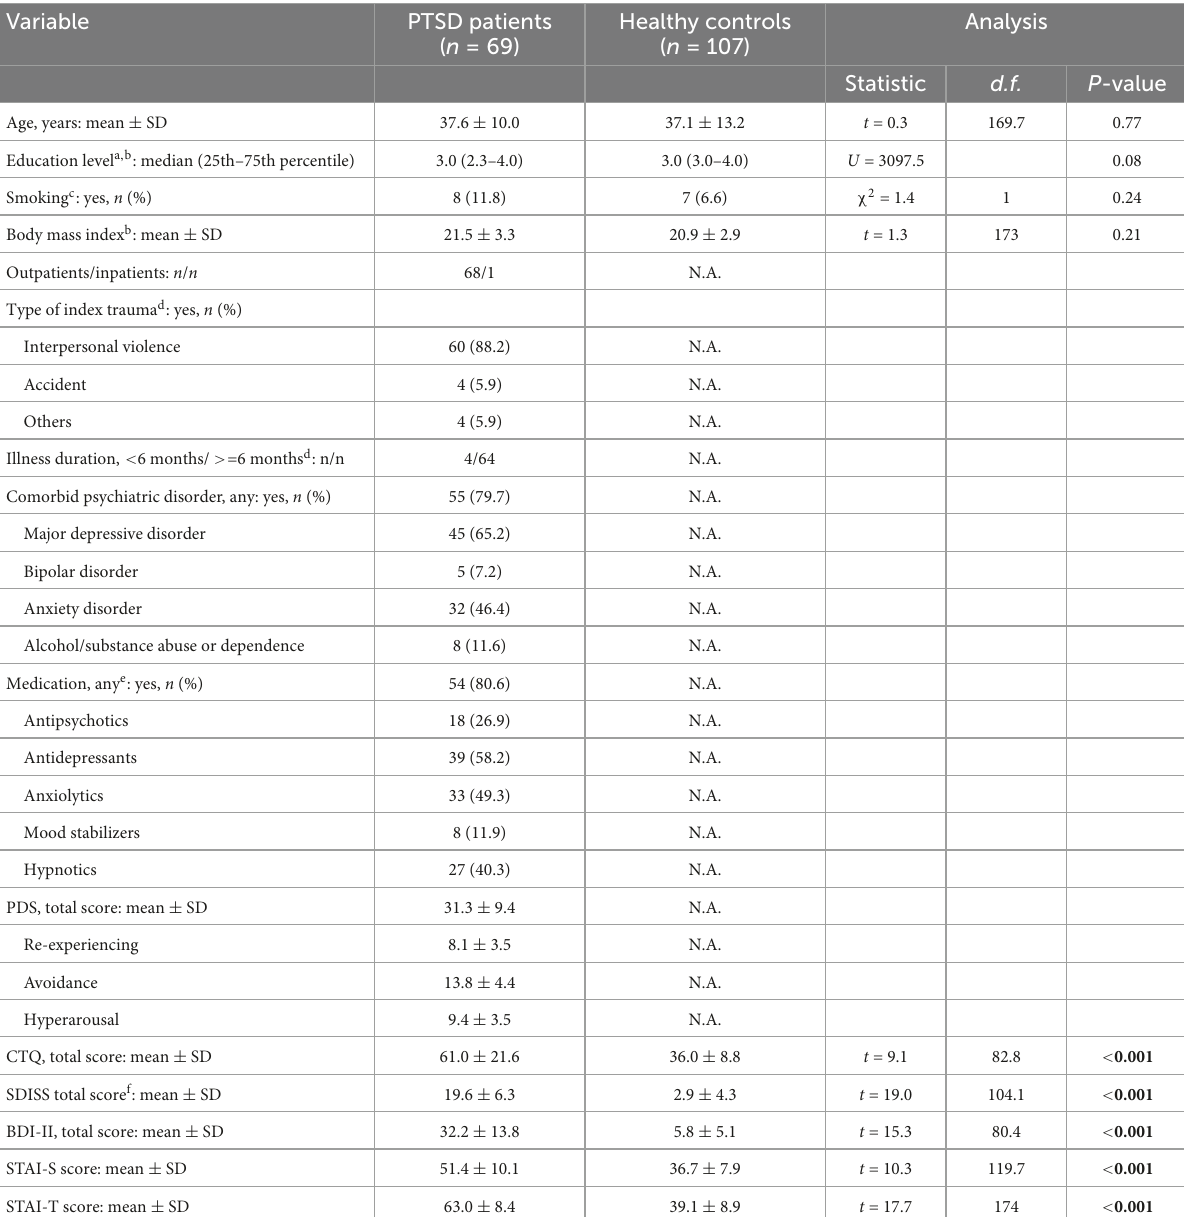
TABLE 1 Demographic/clinical/psychological characteristics in PTSD patients and healthy controls. Variable PTSD patients